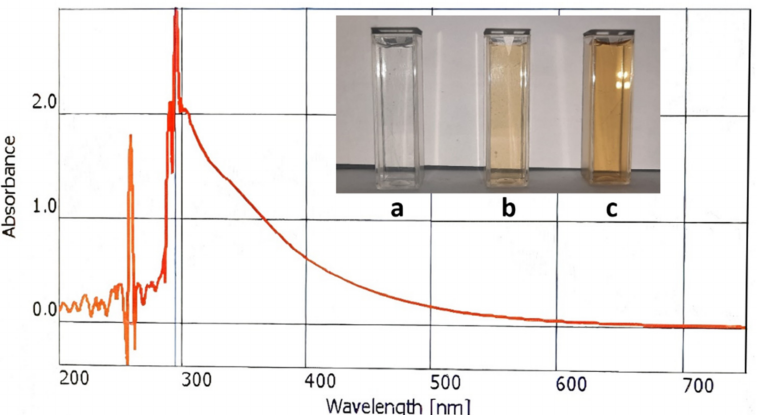
Figure 7. UV-visible spectra of extracted fungal pigment; highest absorbance observed at 295 nm. ( a ) Negative control: distilled water; ( b ) 0.50 mL pigment diluted with 50 mL distilled water; ( c ) 1.0 mL pigment diluted with 50 mL distilled water.